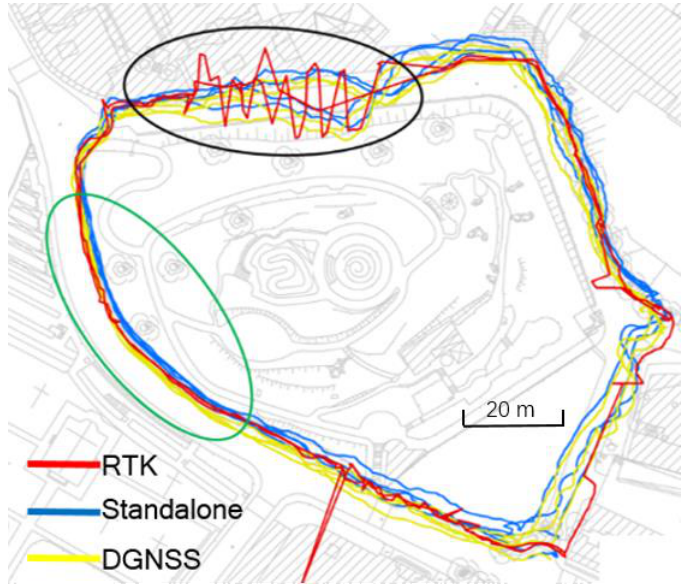
Figure 8. Trajectory of the pedestrian in the urban area.